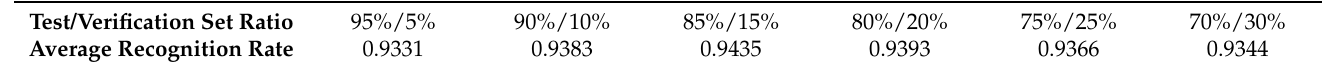
Table 5. The recognition rates of 5 gaits under different test set/verification set